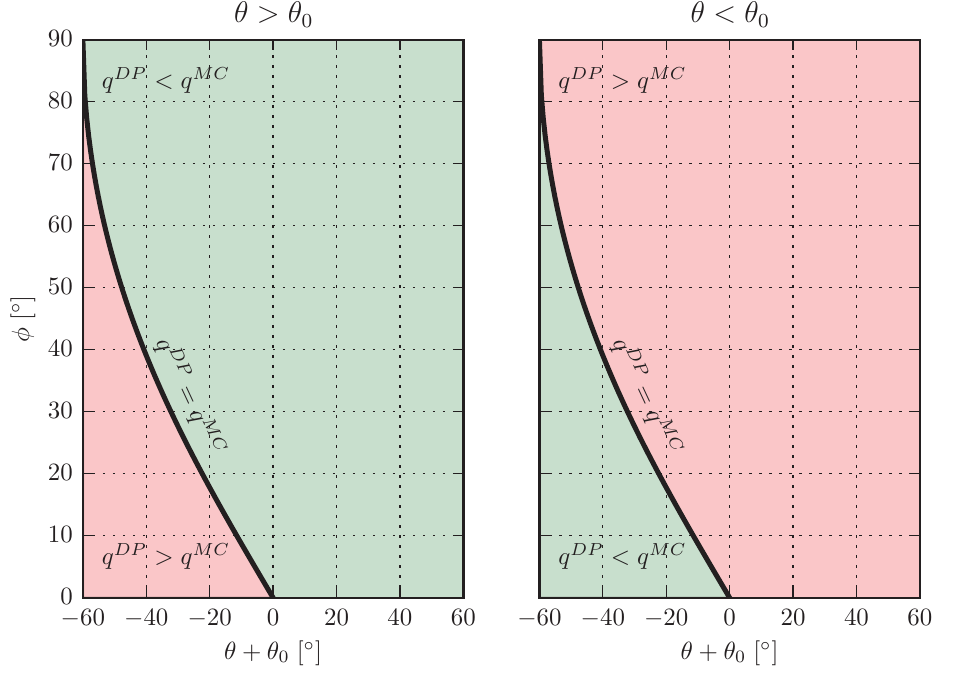
and θ and the friction 0